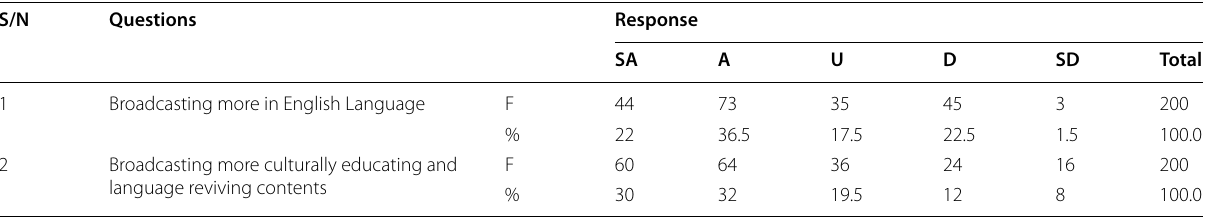
Table 14 Frequency, percentage on statement regarding the ways radio stations can revitalize the use of English language in Hunan